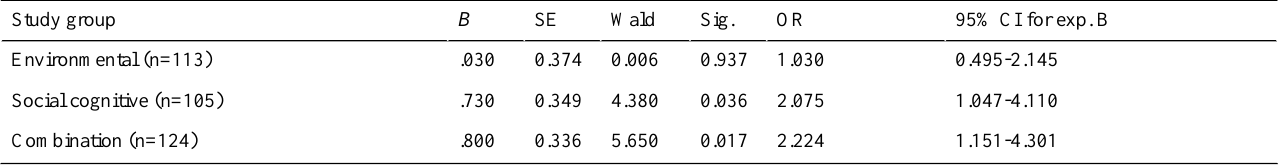
Table 3. Likelihood of meeting PA recommendation results (control group set as reference